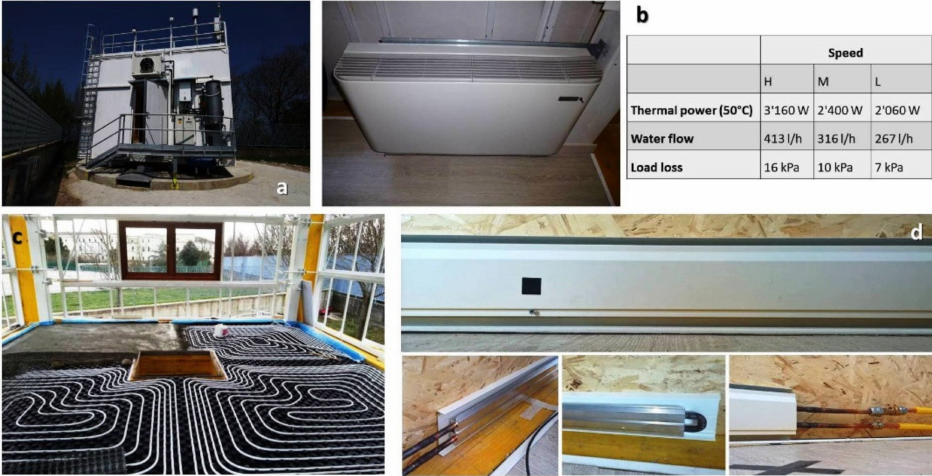
Figure 1. Experimental equipment: ( a ) matrix; ( b ) fan-coil unit; ( c ) radiant floor system; ( d ) heating